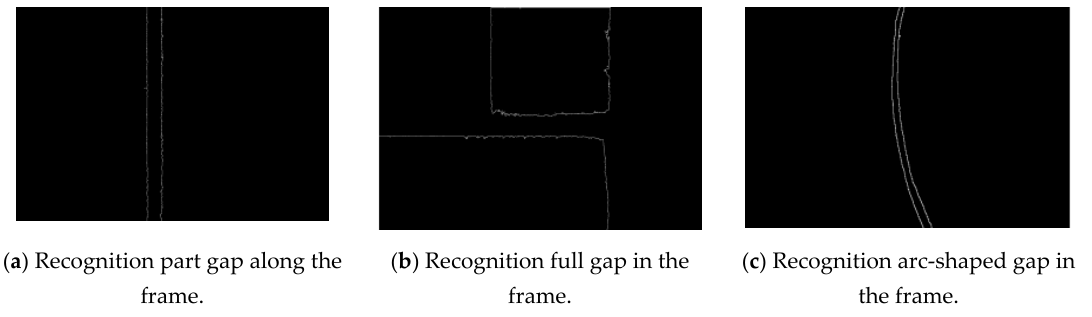
Figure 14. Result of recognition of the gap based on segmentation results.